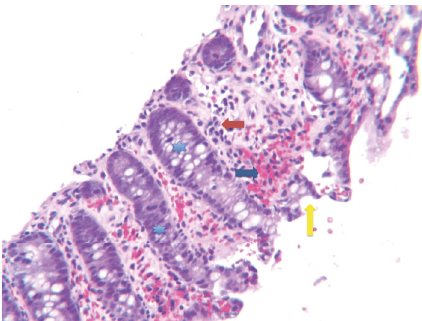
Figure 2: Colonic biopsy. Yellow arrow indicates epithelial surface erosion. Green arrow indicates extravasated red blood cells. Orange arrow indicates lymphocytes. Blue star indicates reactive intestinal